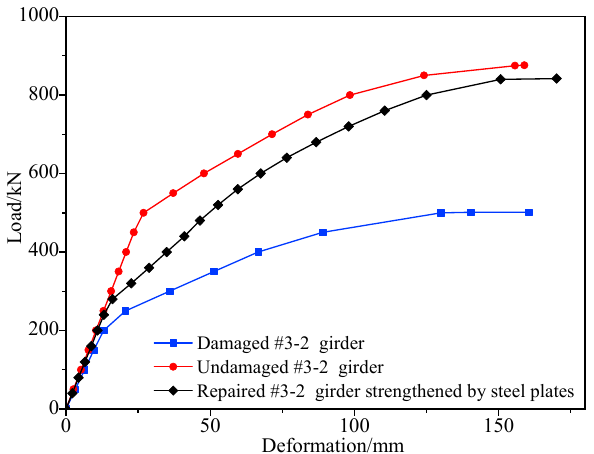
Figure 13. Deformation vs. load from the refined finite element analysis of the #3-2 girder in undamaged, damaged and repaired states.